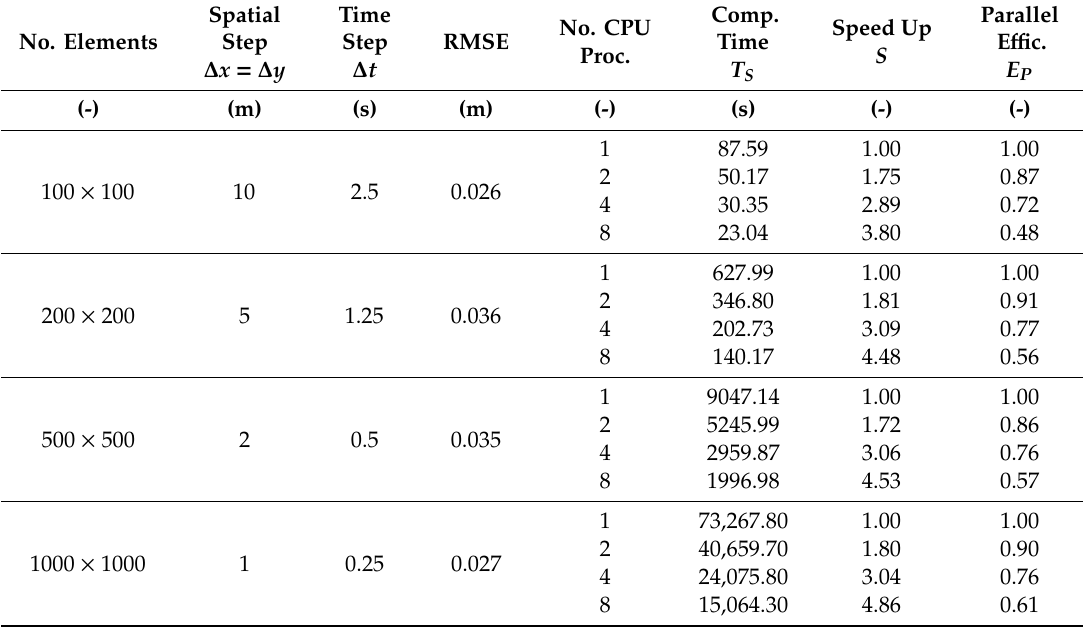
Table 4. Accuracy, efficiency, and statistics (computational time, speed up (Equation (35)), and parallel efficiency (Equation (36)) for parallel computations using the implicit scheme ( θ = 0.65 and ω = 0.7) for the simulation time equal to t = 30,000 s.